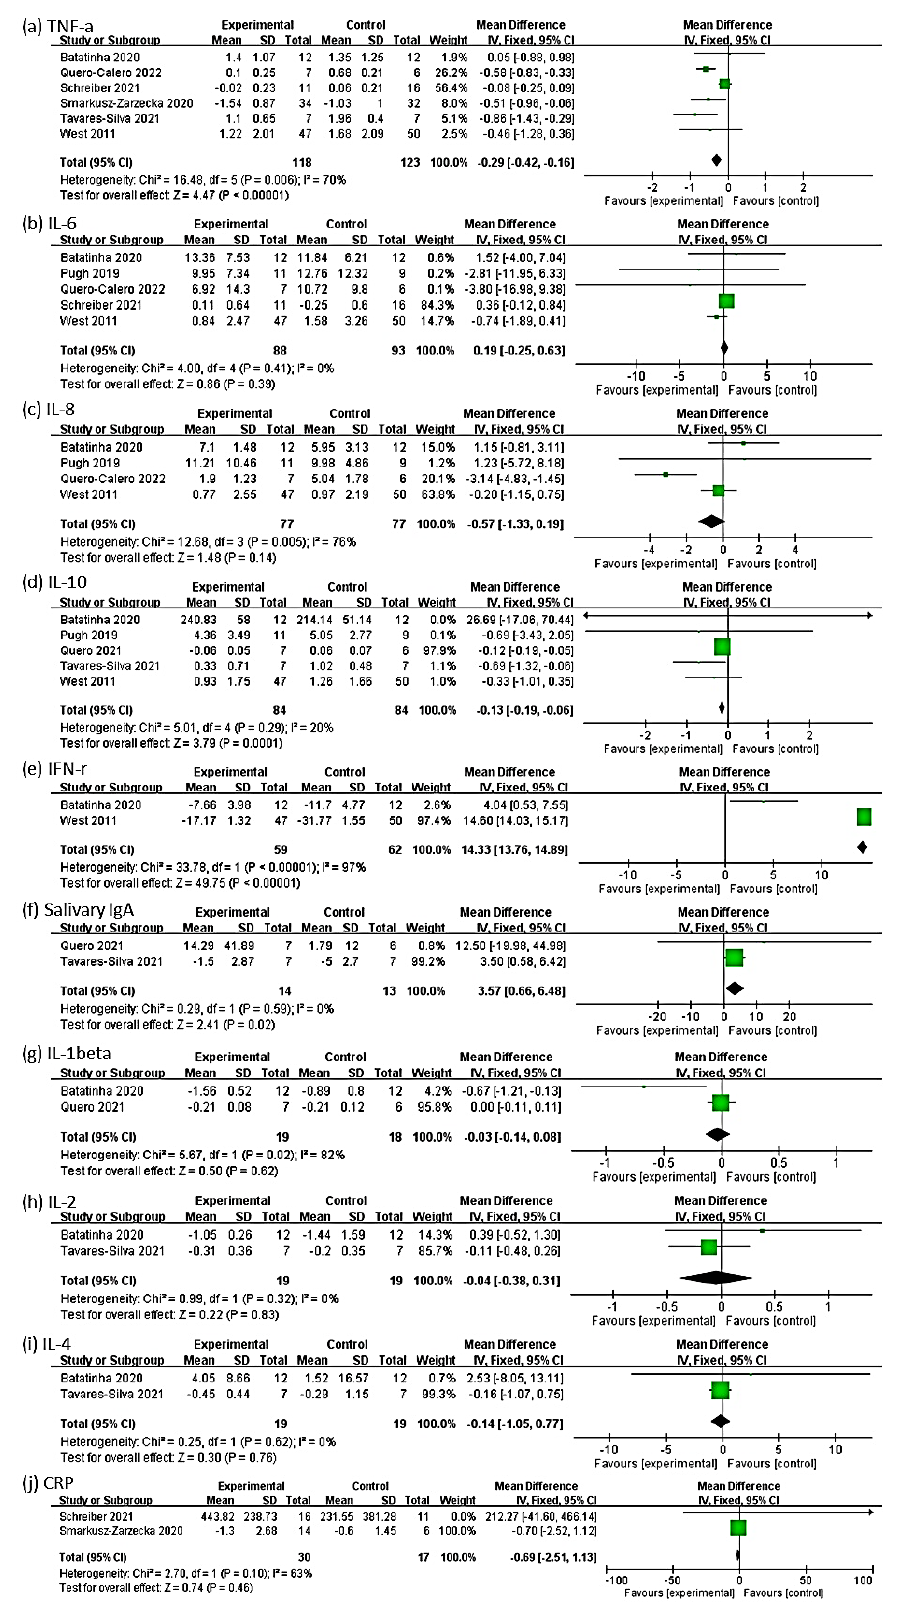
Figure 4. Forest plots of the overall mean effect size for all studies examining the outcomes of ( a ) TNF −α , ( b ) interleukin (IL) − 6, ( c ) IL − 8, ( d ) IL − 10, ( e ) interferon (IFN) −γ , ( f ) salivary immunoglobulin A (IgA), ( g ) IL − 1 β , ( h ) IL − 2, ( i ) IL − 4, and ( j ) C − reactive protein (CRP).